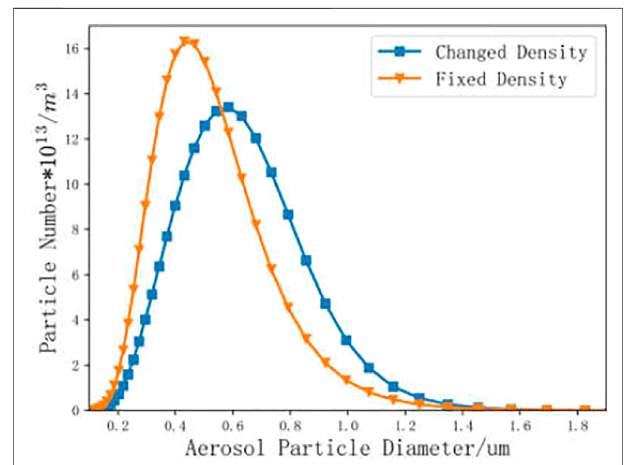
FIGURE 13 | Effect of different densities on the aerosol particle number distribution.